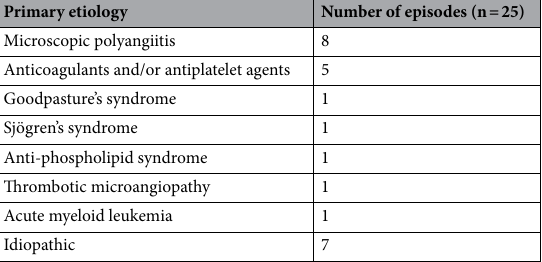
Primary etiology Number of episodes (n =